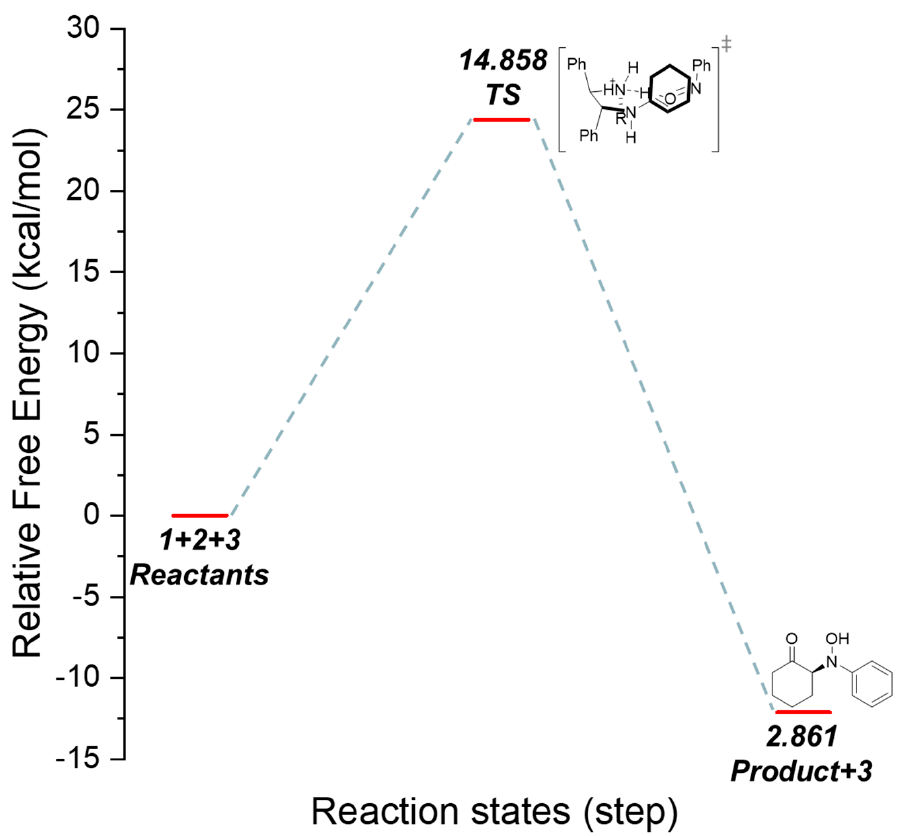
Figure 6. Proposed catalytic mechanism based on the B3LYP/6-31G(d,p) method. The calculations were performed using water conditions. Relative free energy diagram of the ( R , R )-1,2-diphenyl- ethylenediamine (DPEN)-iminium salt catalyzed enantioselective nitroso aldol reaction. The reactants 1, 2, and 3: (1: cyclohexanone, 2: nitrosobenzene, and 3: 1a cat.).